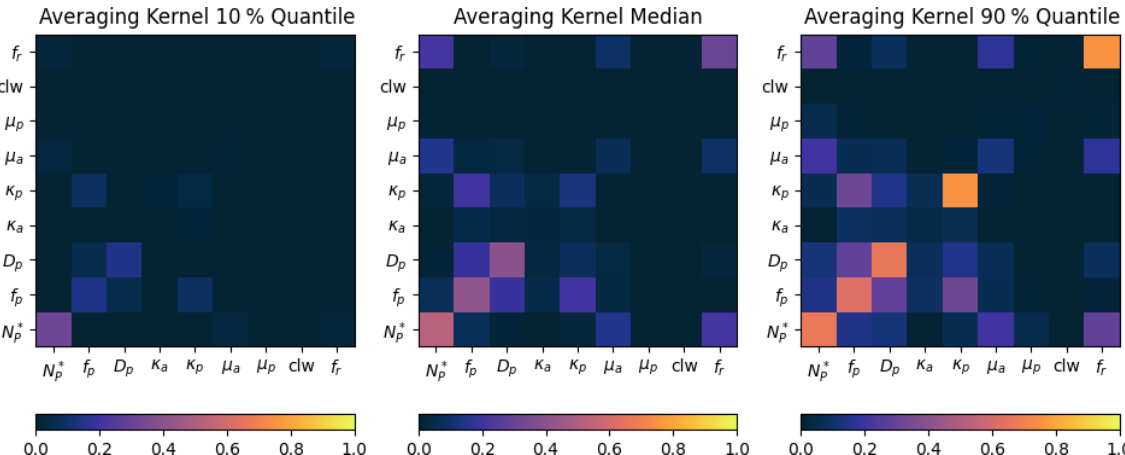
Figure 9. Quantiles of the averaging kernel matrix diagonal elements and off-diagonal elements representing different parameters at the same range